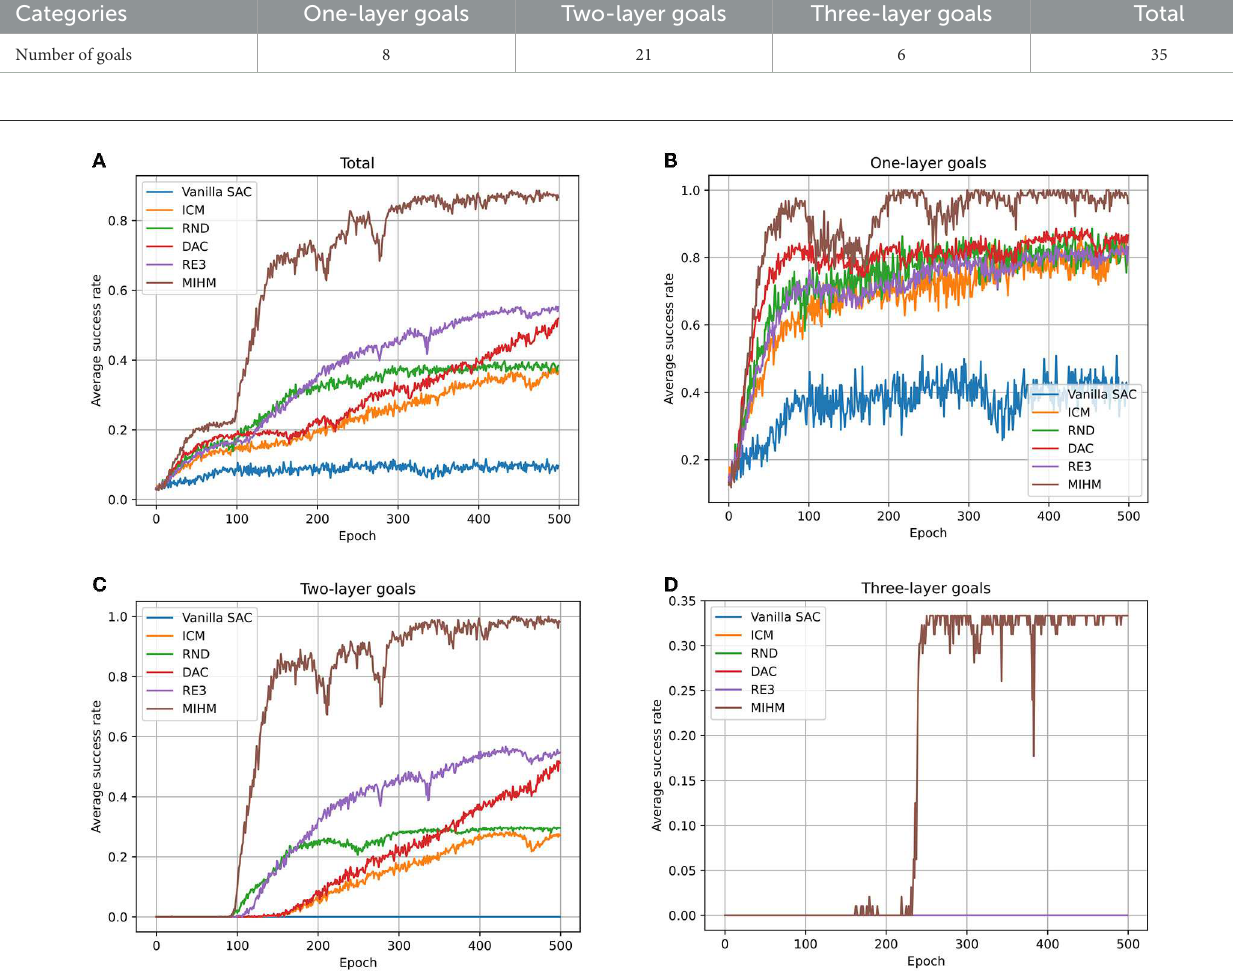
FIGURE4 Learning processes of six algorithms (vanilla SAC, ICM, RND, DAC, RE3 and MIHM) for different categories of goals. (A) Shows the variations of average success rates of all 35 goals. (B–D) Show the variations of the average success rates of one-layer goals, two-layer goals and three-layer goals, respectively. Vanilla SAC agent can only achieve some of the one-layer goals with low success rates. ICM, RND, DAC, and RE3 enable the agent to achieve most of the one-layer goals and some of the two-layer goals. Comparatively, our MIHM enables the agent to learn all one-layer goals and two-layer goals. For the three-layer goals, our MIHM obtains an average success rate of 33%.